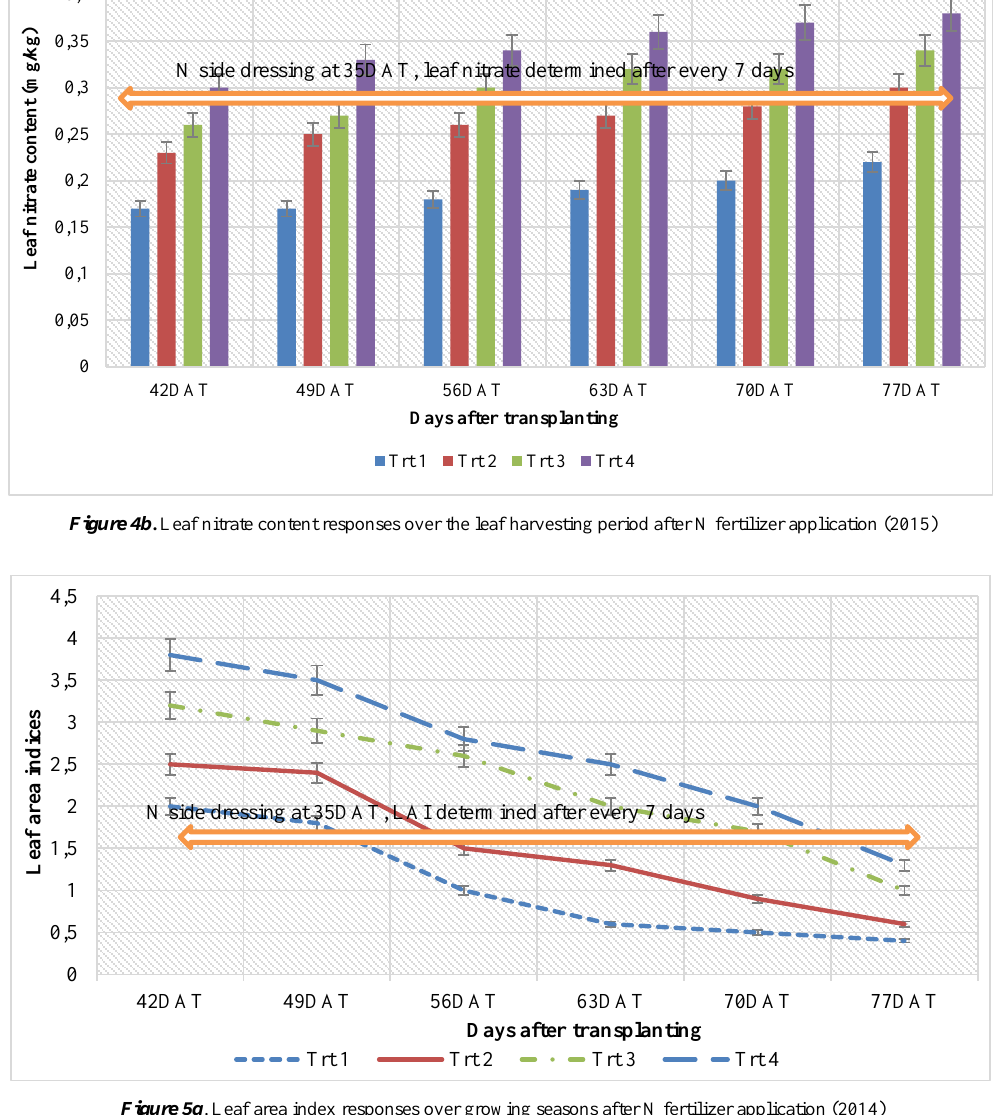
Figure 5a . Leaf area index responses over growing seasons after N fertilizer application (2014)